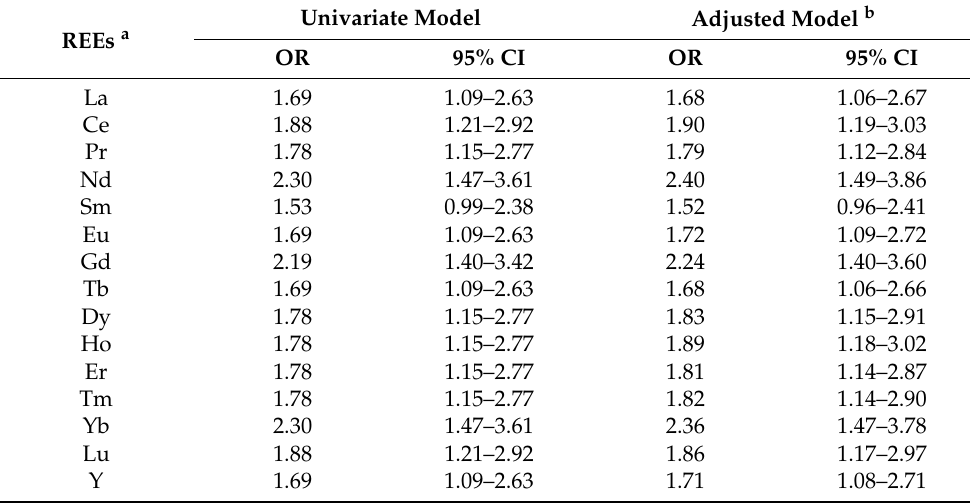
Table 3. Logistic regression models for binary variables of 15